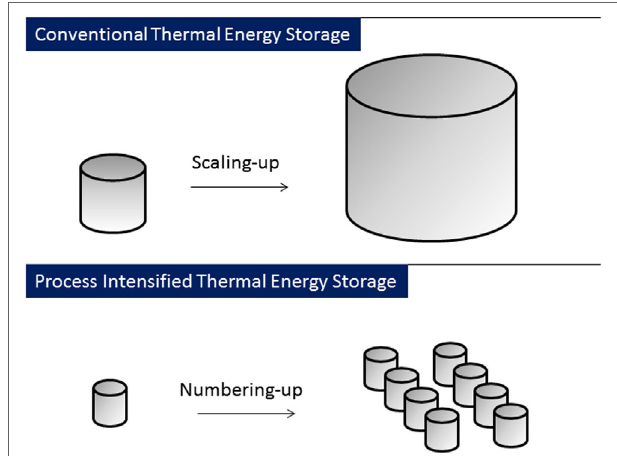
FigURe 2 | Thermal energy storage system using process intensification technologies hold advantages such as size reduction, modular integration facility, and better performances.